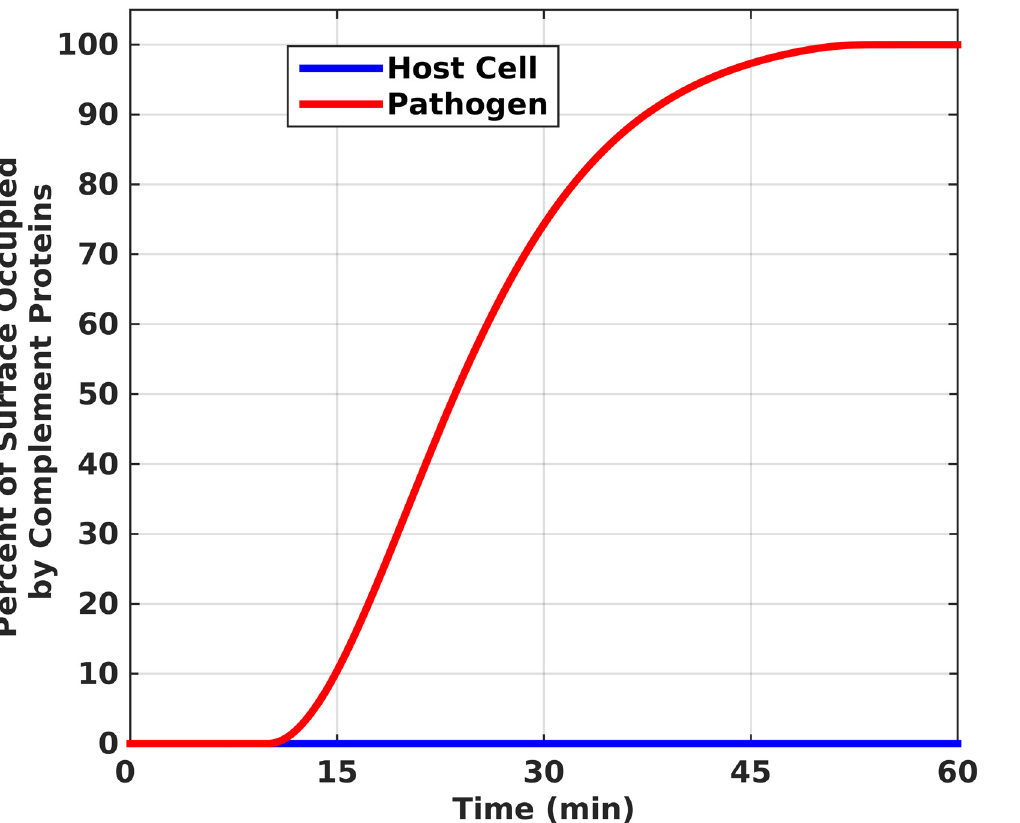
Fig 2. Complement deposition on pathogen and host surfaces. Saturation of pathogen surface is reached in 54 minutes with complement proteins such as C3b, iC3b, iC3bP (pathogen), C3dg, C3/C5 convertases, properdin (P * ), MAC, and intermediates such as C3bB, C3bBP, C5b6-7, C5b6-8, and others. Propagation of the alternative pathway is inhibited on host cells resulting in complement proteins occupying significantly less than 1